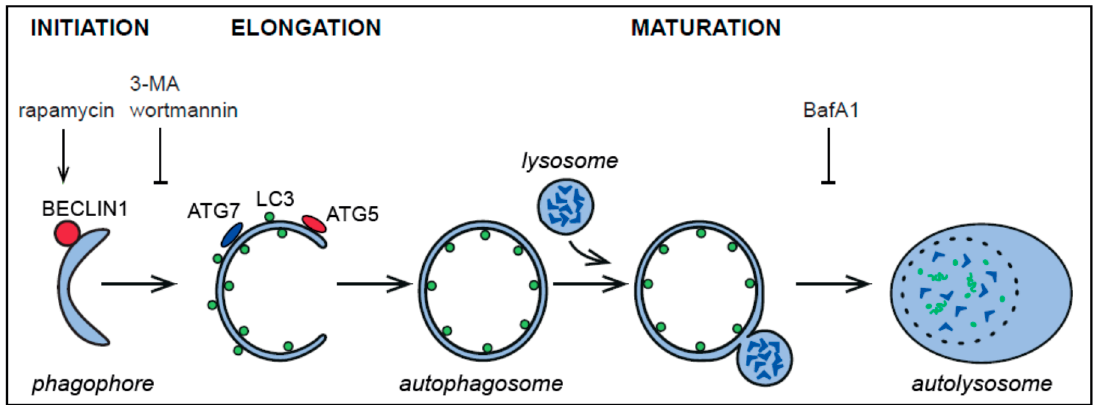
Figure 3. Overview of autophagy in mammalian cells. Schematic representation of the autophagic flux, some of its main regulators and of the effects of compounds commonly used to modulate autophagy. 3-MA: 3-methyladenine; BafA 1 : bafilomycin A 1, LC3: microtubule-associated protein light chain